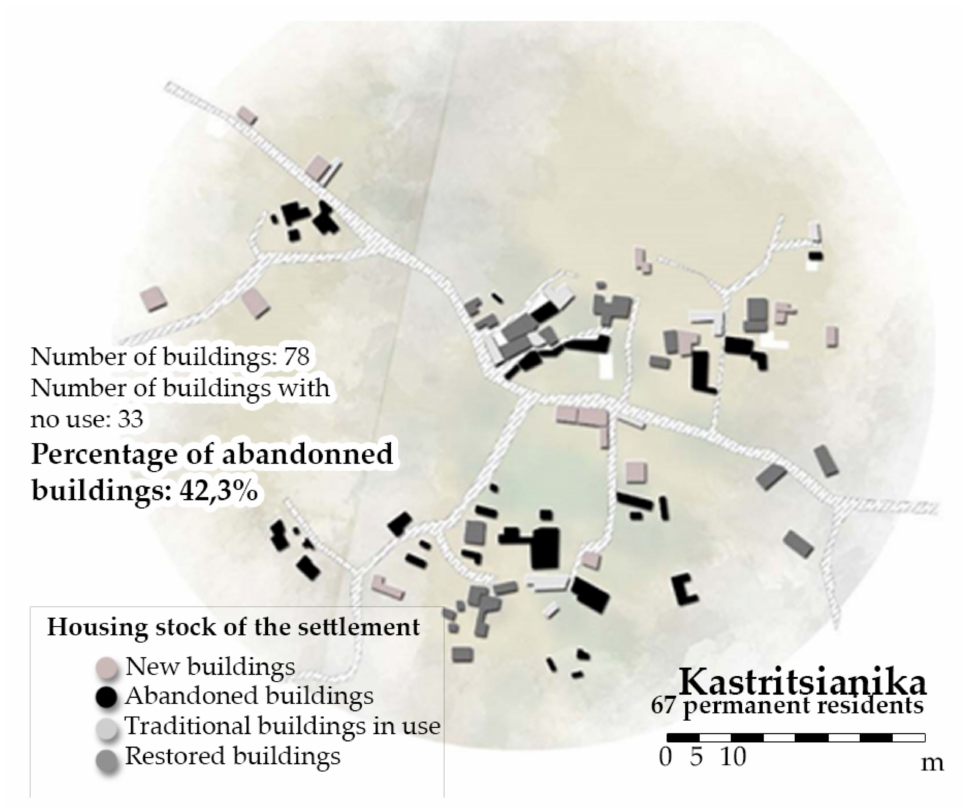
Figure 26. The housing stock of